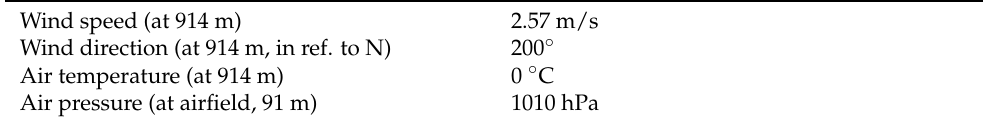
Table 2. Meteorological data during the test flight.